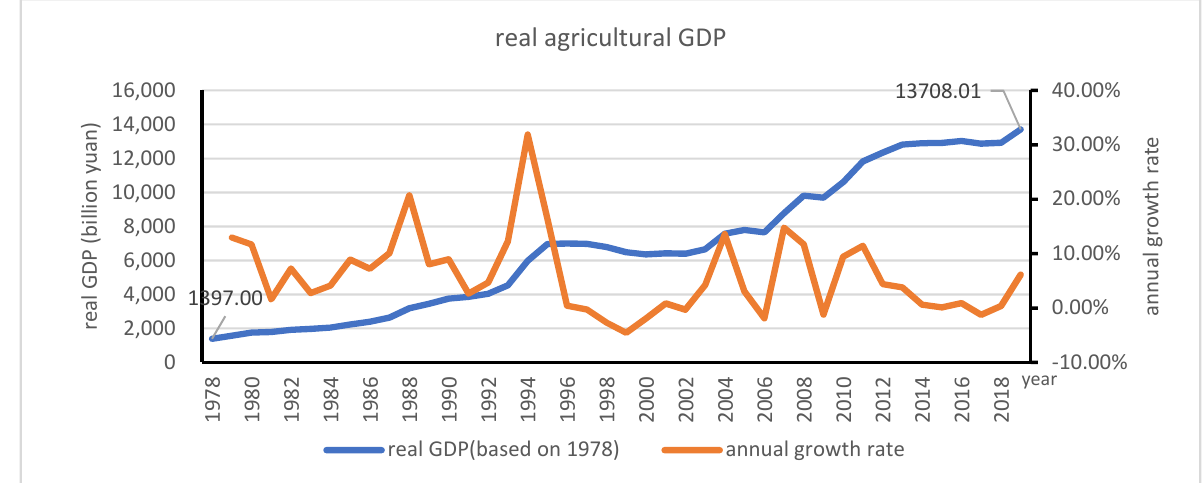
Figure 9. Development of broad agriculture in China.